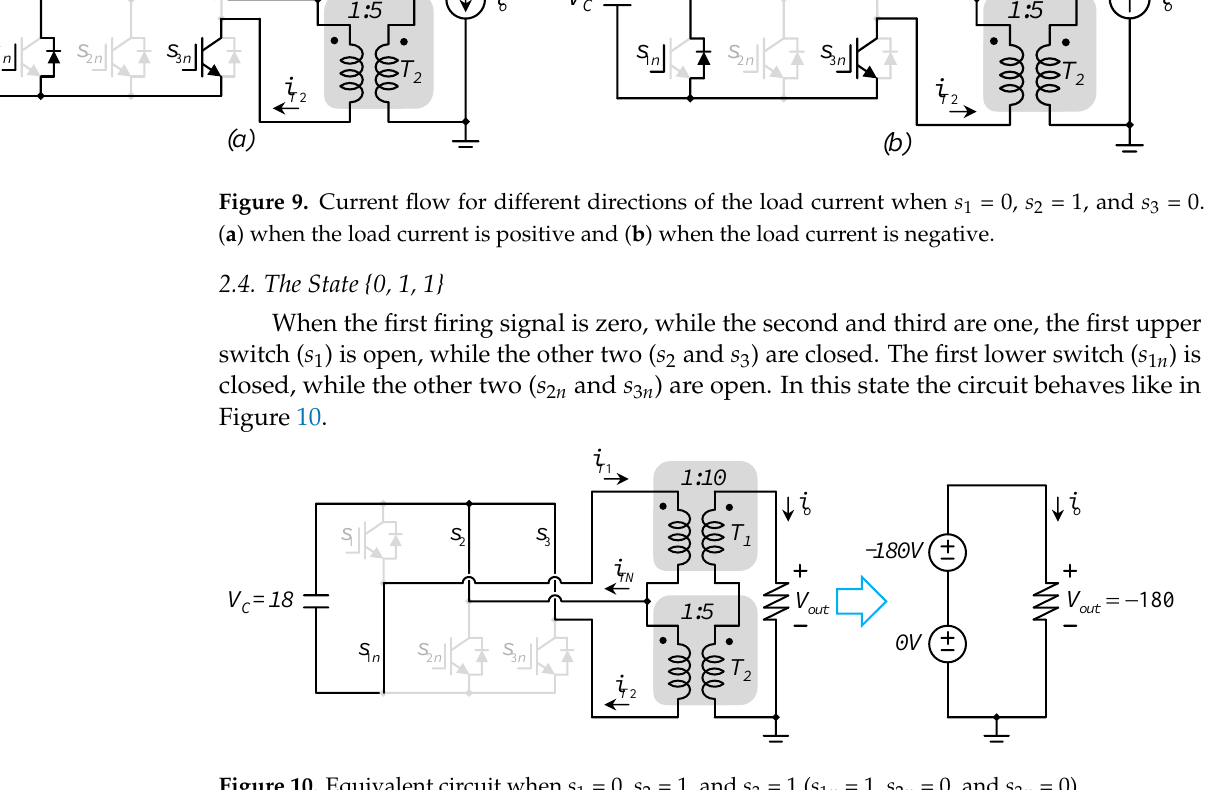
Figure 10. Equivalent circuit when s 1 = 0, s 2 = 1, and s 3 = 1 ( s 1 n = 1, s 2 n = 0, and s 3 n = 0). The primary winding of the transformer T 1 is connected to the input source, but the dot at the primary winding coincides with the negative side of the input power source and T 1 provides a negative voltage ( − 180 V). The primary winding of the transformer T 2 is shorted or connected to zero volts (it is not contributing to the output voltage in this switching state). In this state, the inverter provides an output of − 180